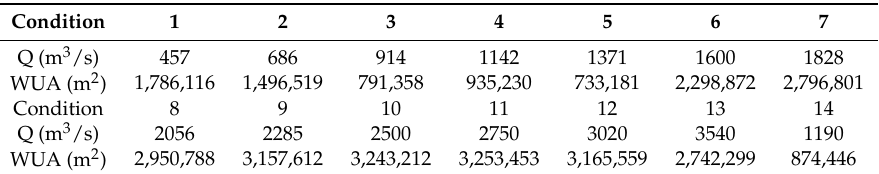
Table 3. WUA of the study area during different